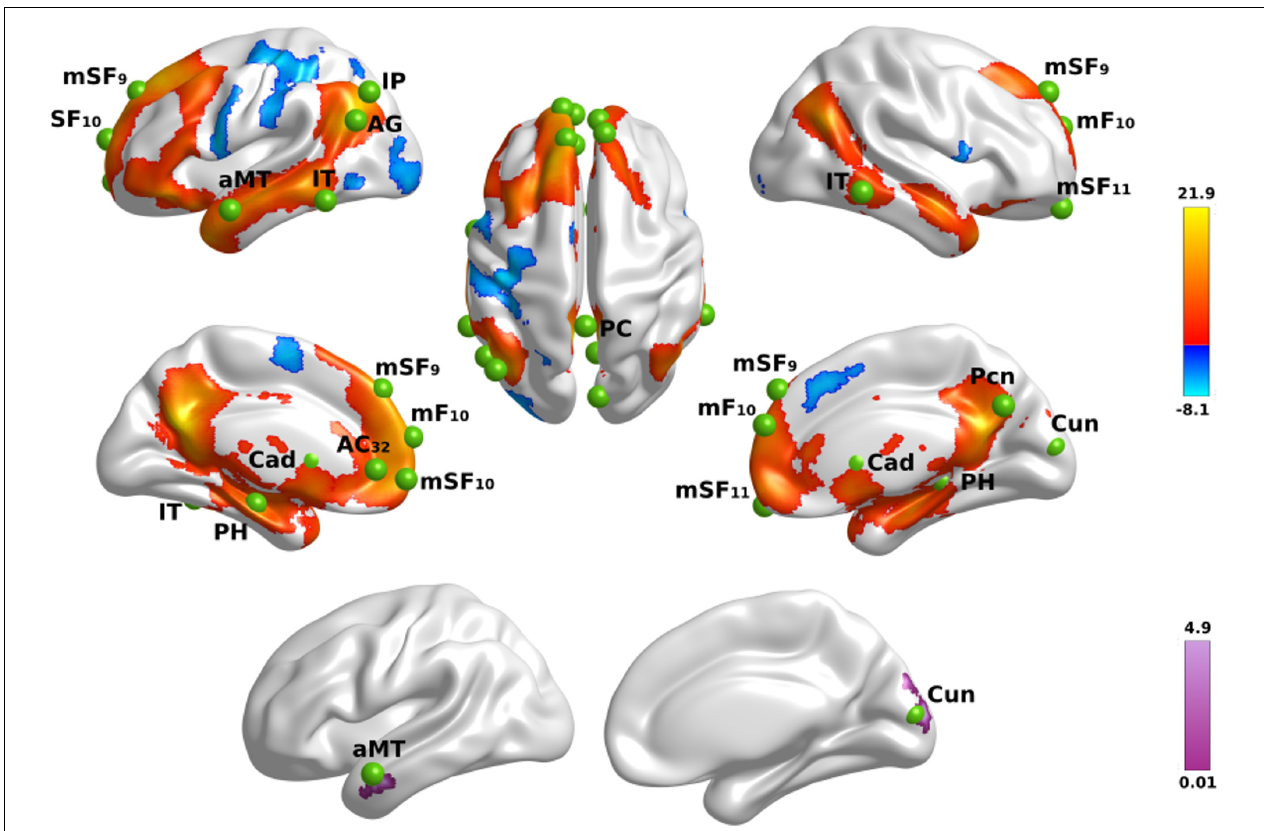
FIGURE 1 | Name familiarity effects on brain activation. Top rows display left and right hemisphere regional activations from voxelwise tests of name familiarity in all participants. Warm colors designate activations that were greater for familiar than unfamiliar names and cool colors designate activations that were greater for unfamiliar than familiar names. The bottom row displays areas showing group differences in the effects of name familiarity. Color bars show the range of F values for significant effects, which are detailed in Supplementary Table 2 . Green balls illustrate the locations of seed regions of interest, which were used in the gPPI analyses. Nineteen seeds were placed in areas showing significantly greater activation for famous than unfamiliar names (see Supplementary Table 3 for seed coordinates). Brodmann areas for frontal seeds are designated by subscripts. AC, anterior cingulate; AG, angular gyrus; aMT, anterior middle temporal; Cad, caudate; Cun, cuneus; IP, inferior parietal; IT, inferior temporal; mF, medial frontal; mSF, medial superior frontal; Pcn, precuneus; PC, posterior cingulate; PH, parahippocampus; SF, superior frontal.